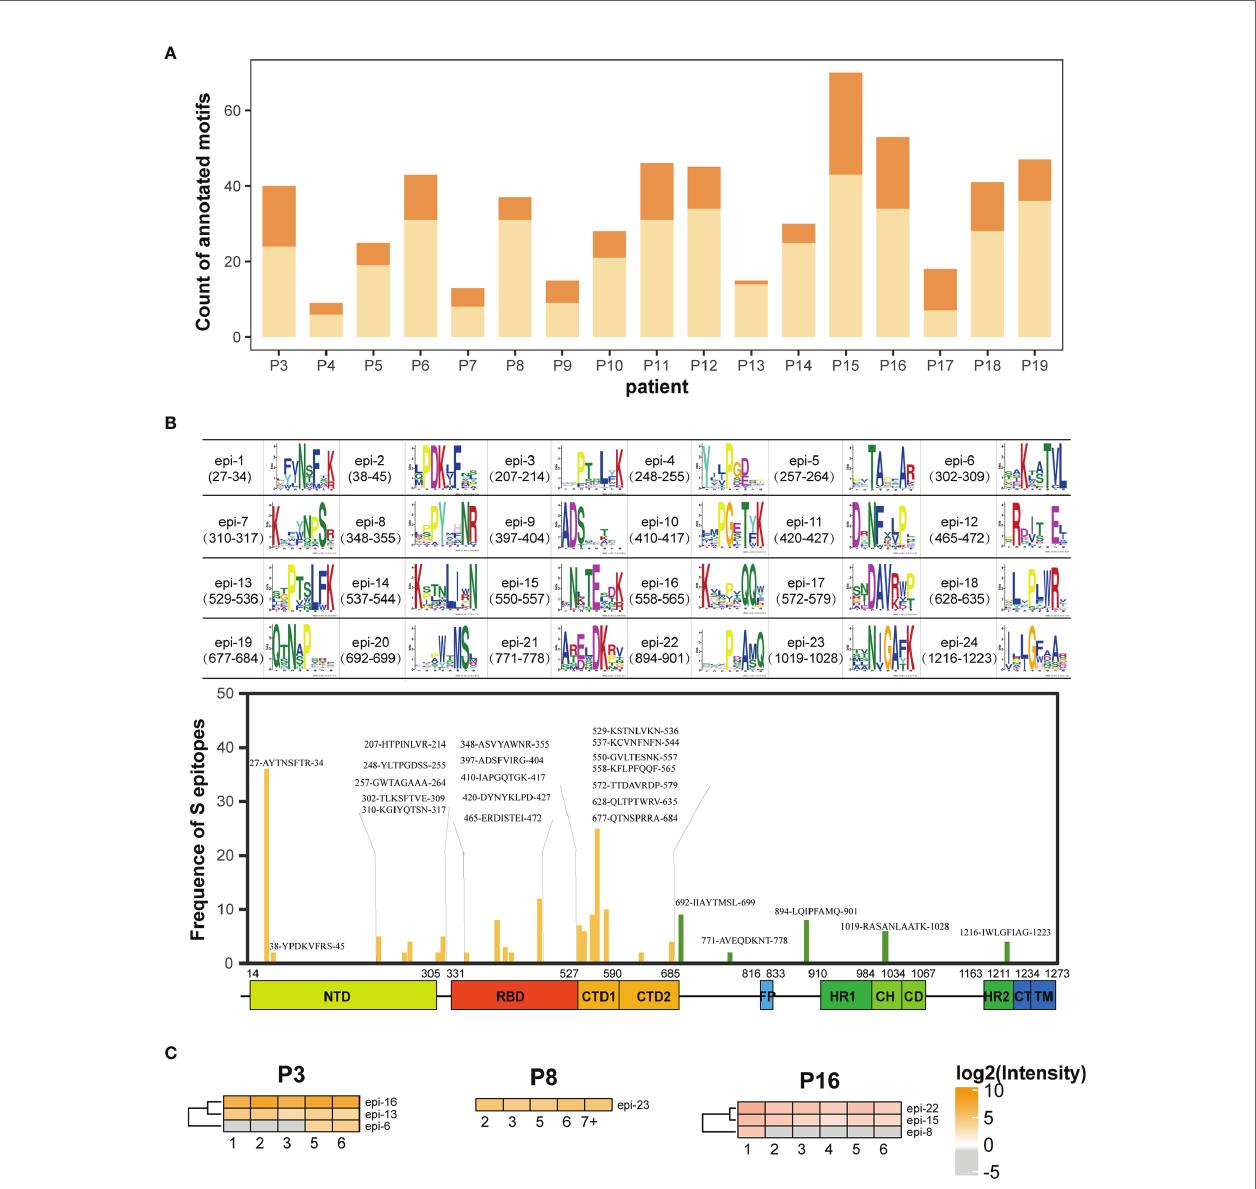
FIGURE 4 | AbMap analysis to identify epitopes with a random peptide library for S1-speci fi c antibodies enriched from the COVID-19 sera. (A) Distribution of annotated motifs identi fi ed by AbMap in all the COVID-19 patients; motifs matched to the S protein are shown in dark orange and unmatched motifs are shown in light orange. (B) Frequency distribution of epitopes recognized by the puri fi ed IgG antibodies against the S1 protein in all COVID-19 sera. The upper panel represents 24 structures of matched motifs. The lower panel illustrated frequency distribution of 24 epitopes along the S protein sequence. The x axis represents the entire S gene sequence and the color bars at the bottom denote the different domains as indicated in Figure 2B . The y axis represents frequency of epitopes detected in the COVID-19 patients. The yellow and green bars indicate epitopes located in the S1 and S2 subunits, respectively. (C) Heatmaps of the S epitopes recognized by the puri fi ed IgG in the three COVID-19 patients, P3, P8 and P16. The gray cells indicate unmatched S epitopes identi fi ed from the corresponding samples. The x axis of heatmap indicates the time intervals (week) during the hospitalization after symptom